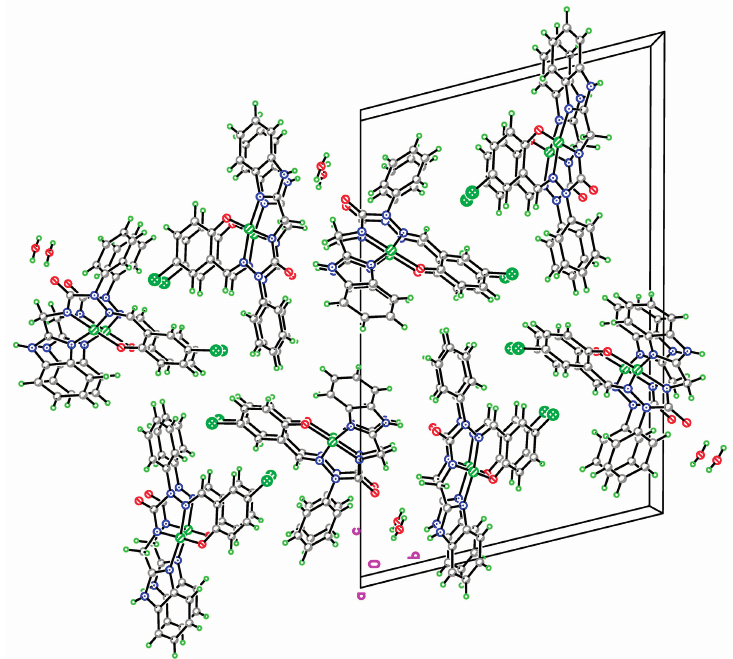
Figure 7. The packing diagram of complex 16a crystallized with water